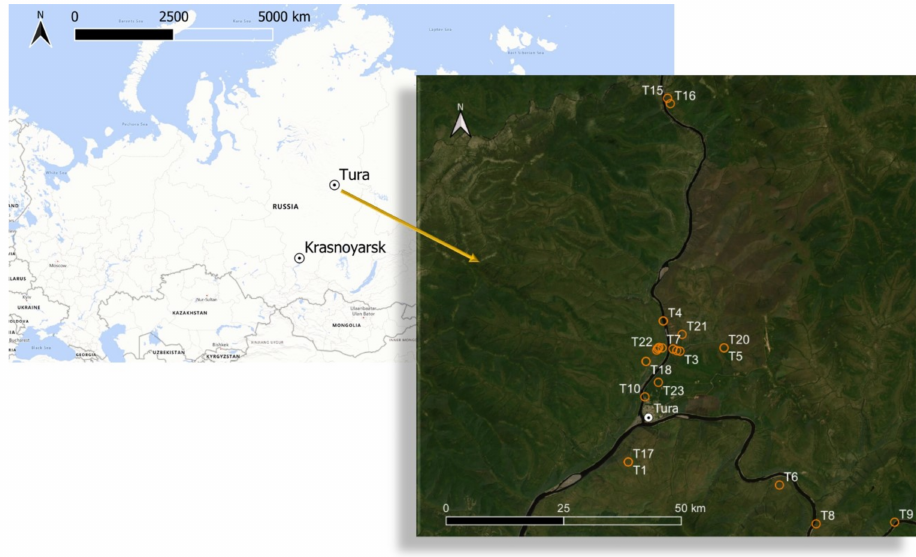
Figure 1. Study site locations and